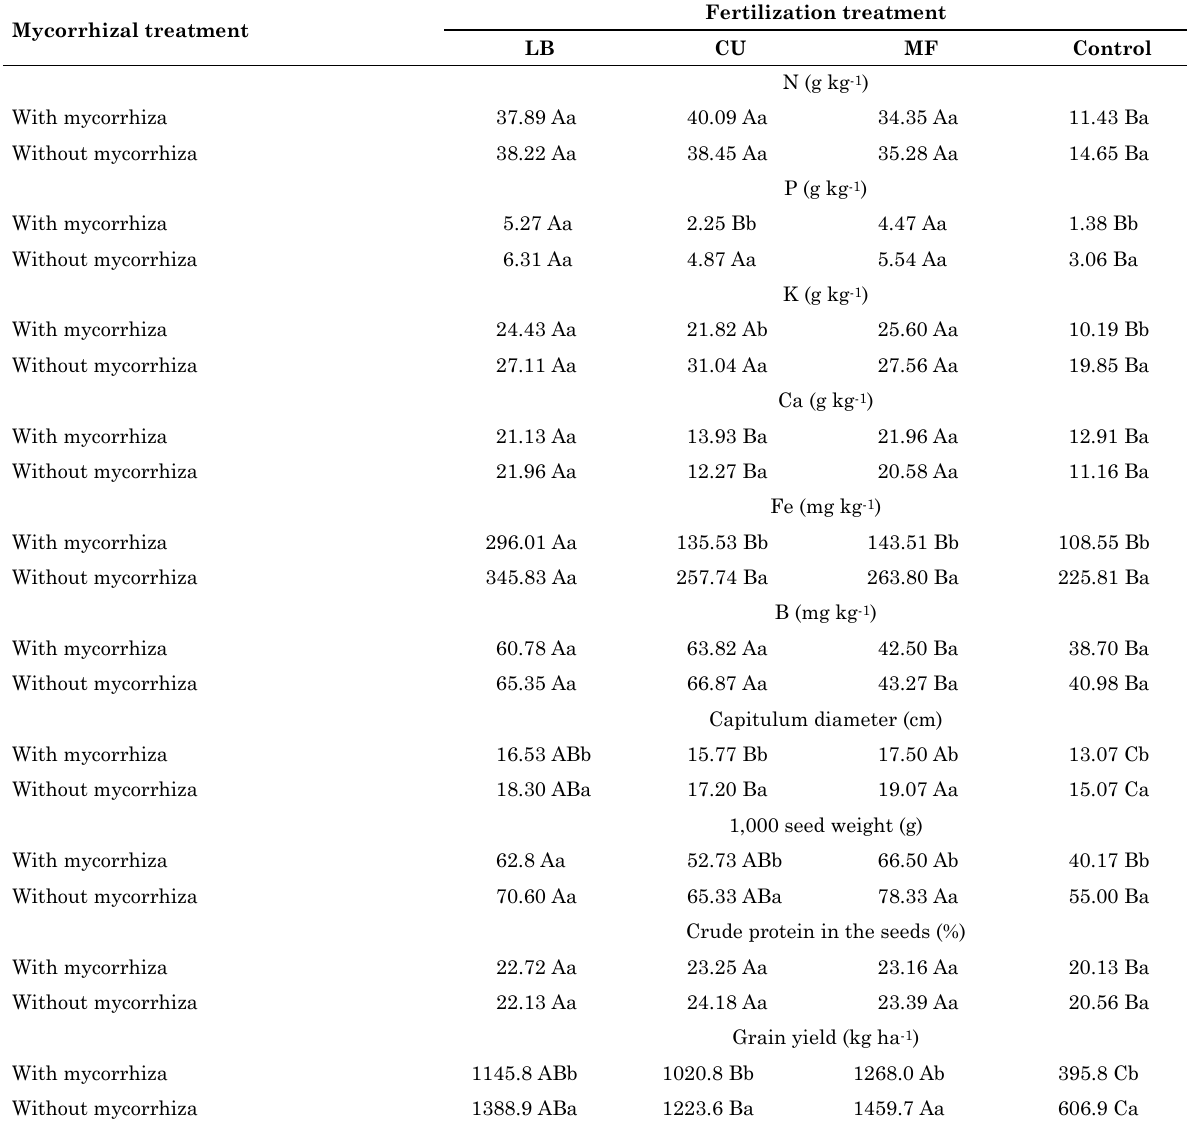
Table 3. Macro- and micronutrients in shoot dry matter of sunflower, capitulum diameter, 1,000 seed weight, crude protein in the seeds, and yield of sunflower as a function of the treatments studied Mycorrhizal